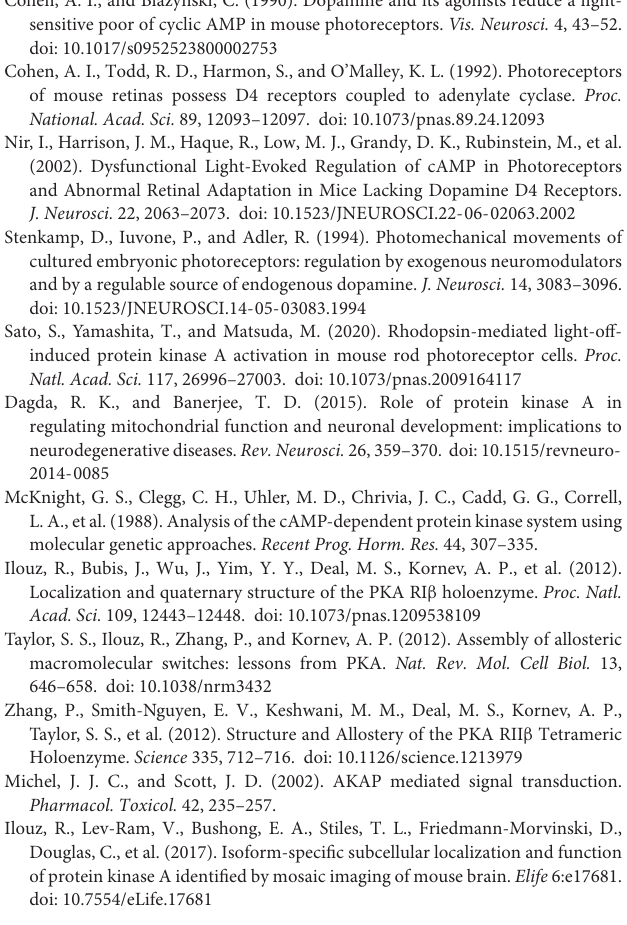
is expressed in inner segment ellipsoid, while RII α is localized to photoreceptor cell body and axon. Nuclei in blue, scale bar = 10 mm. Supplementary Figure 4 | Airyscan images of RII β + RII α in photoreceptor cells. Z-stack Airyscan images confirm intracellular localization of RII β (green, RII β ) and RII α (red, RII α ), with clear co-localization of RII β and RII α (yellow, Merge) in the cell body and axon of cone cells. Nuclei in blue, scale bar = 10 mm. Supplementary Figure 5 | Airyscan images of C β + mitochondria. Cb (green) and OxPhos(red)-labeled mitochondria co-localize in the ONL, INL, and RGC, with clear signal overlap (yellow) in every cell layer. Nuclei in blue, scale bar = 10 mm. Supplementary Figure 6 | Z-stack images of C β + mitochondria. Nine z-stack Airyscan images highlight intracellular localization of C β and mitochondria co-localization (yellow). As the panels move from image 1 (top stack, blue line) to image 9 (bottom stack, blue line) it is clear that C β is continuously co-localized mitochondria in throughout the entire photoreceptor inner segment. Blue line = z position (primary image), green line = top panel, red line = right panel. Green and red lines highlight localization in an individual cell, which can be further visualized in the top and right panel. Supplementary Figure 7 | Z-stack images of C α + mitochondria. Nine z-stack Airyscan images highlight intracellular localization of C α (green) with respect to mitochondria (red). As the panels move from image 1 (bottom stack, blue line) to image 9 (top stack, blue line) it is clear that C α is continuously expressed in the outer segment membrane. There is clear signal from C α (green) at the top of the